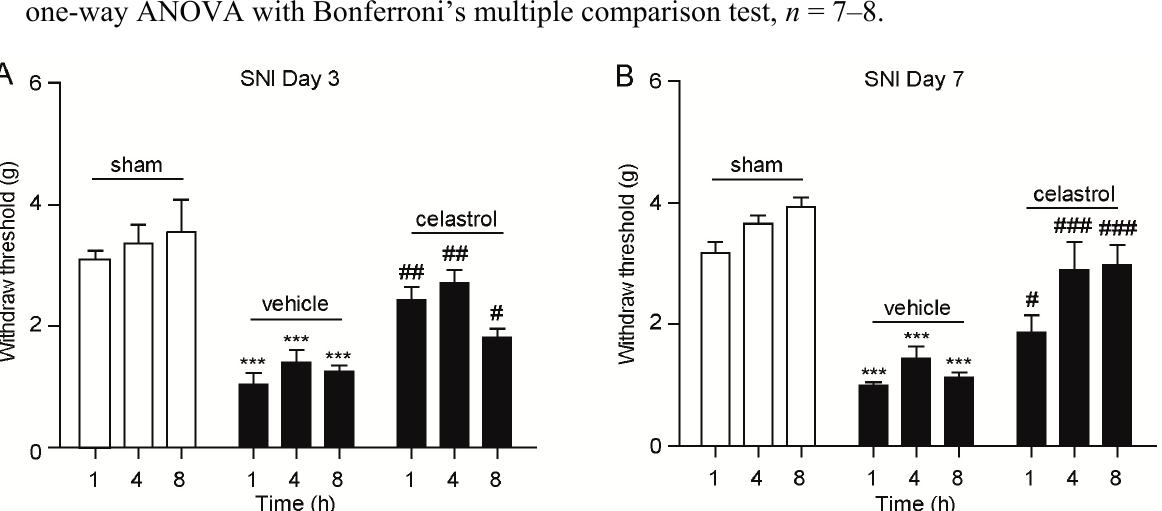
Figure 4. Celastrol reduced hyperalgesia in SNI mice. The time-course effect of vehicle (5% PEG/5% Tween-80 in saline, 10 mL/kg, i.p.) and celastrol (1 mg/kg, 10 mL/kg, i.p.) on mechanical allodynia in SNI mice (closed bars) on the third day post-surgery ( A ); and the seventh day post-surgery ( B ). Sham, sham-operated mice (open bars); 1, 1 h after drug administration; 4, 4 h after drug administration; 8, 8 h after drug administration. *** p < 0.001 vs. Sham-operated mice; # p < 0.05, ## p < 0.01, ### p < 0.001 vs.